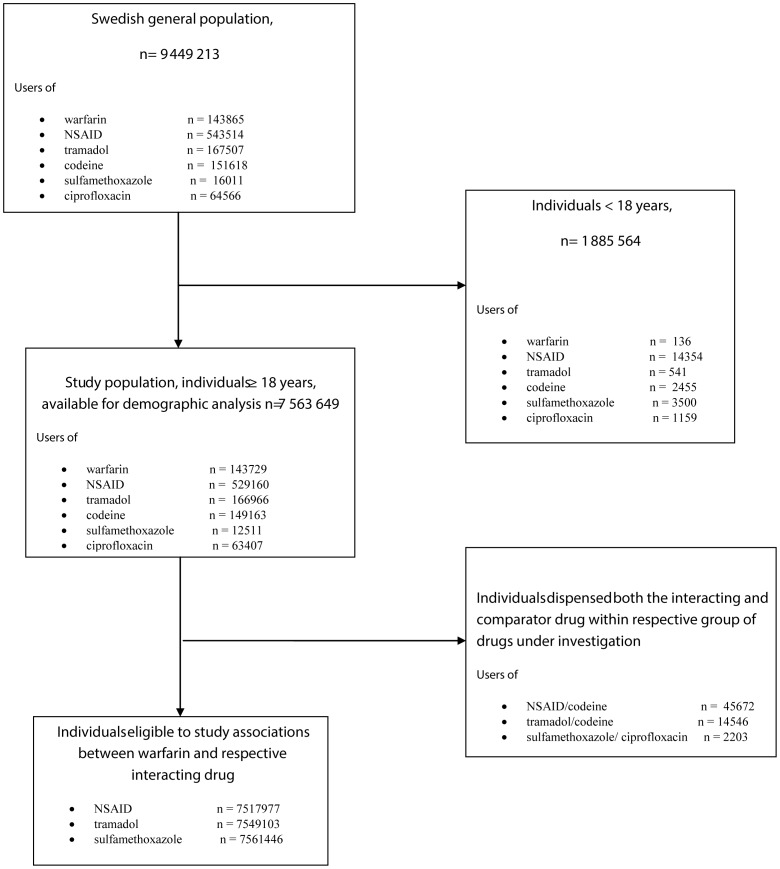
Patient flow chart.